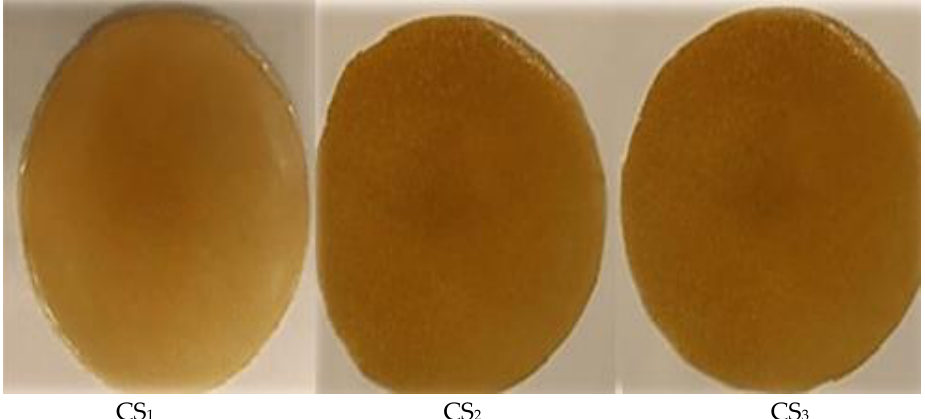
Figure 4. Images of obtained silver